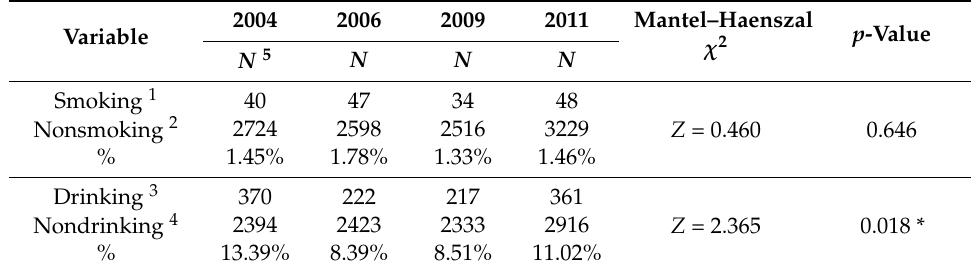
Table 2. Trends of alcohol and tobacco consumption among adult women of reproductive age